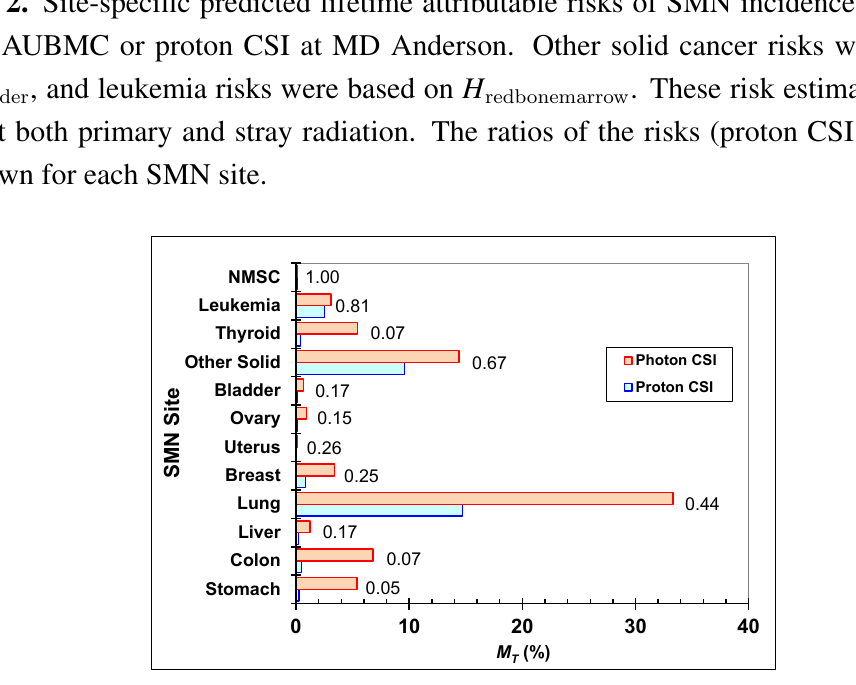
Figure 3. Site-specific predicted lifetime attributable risks of SMN mortality after photon CSI at AUBMC or proton CSI at MD Anderson. Other solid cancer risks were based on H remainder , and leukemia risks were based on H red bone marrow . These risk estimates took into account both primary and stray radiation. The ratios of the risks (proton CSI:photon CSI) are shown for each SMN site.